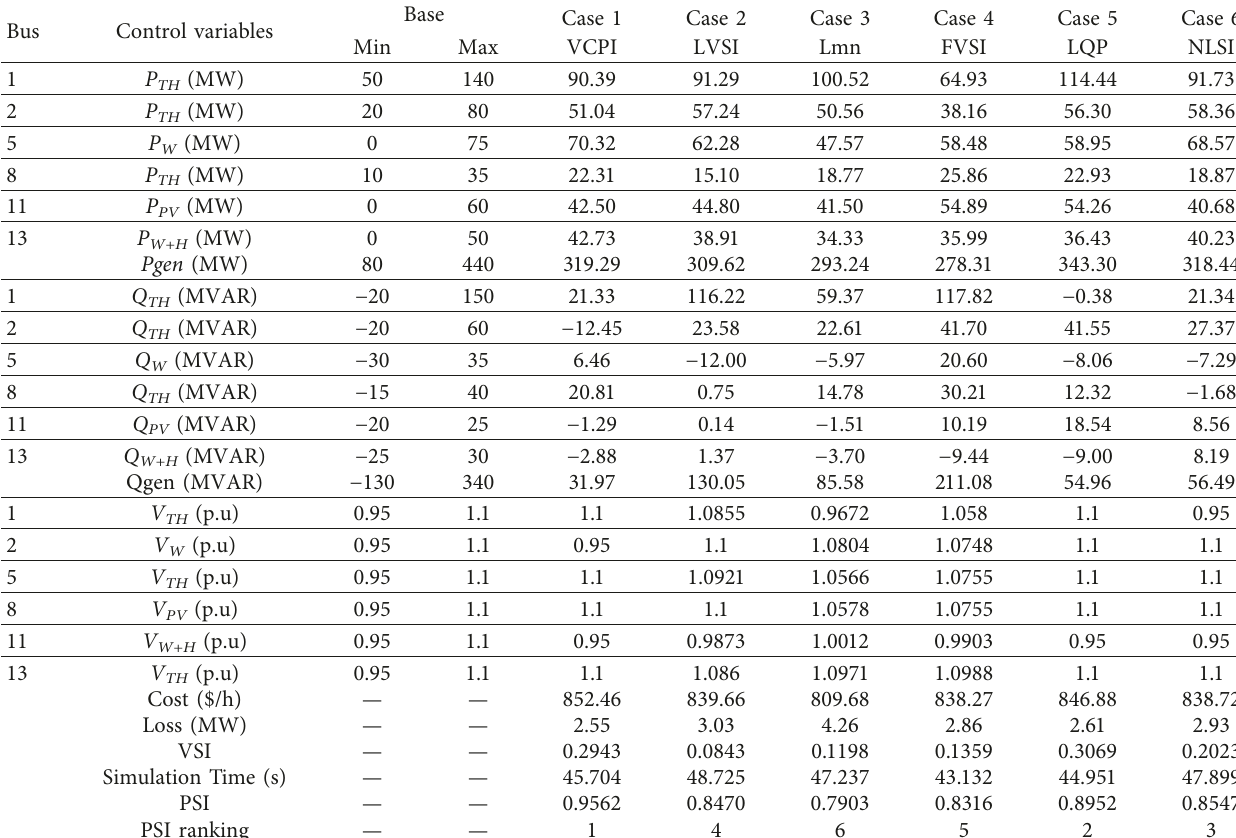
Table 7: Best compromise solutions from the different case studies in SC-1.